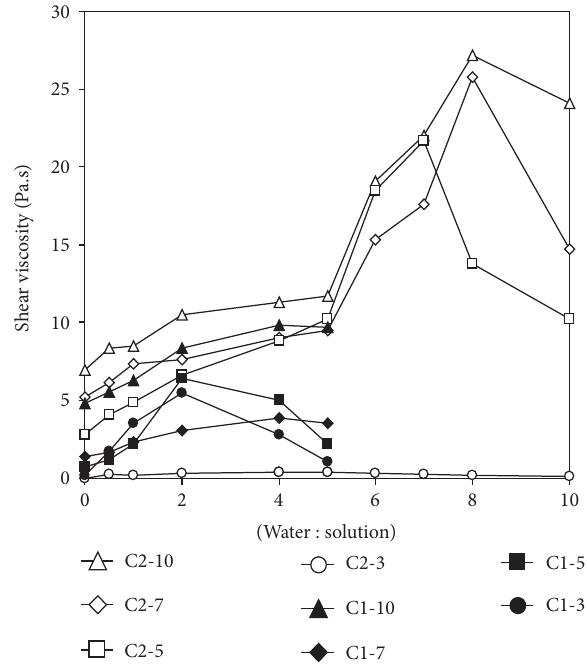
Figure 4: Shear viscosity of the chitin-DMAc solution with the added water in different amounts at 0.63s − 1 of the shear